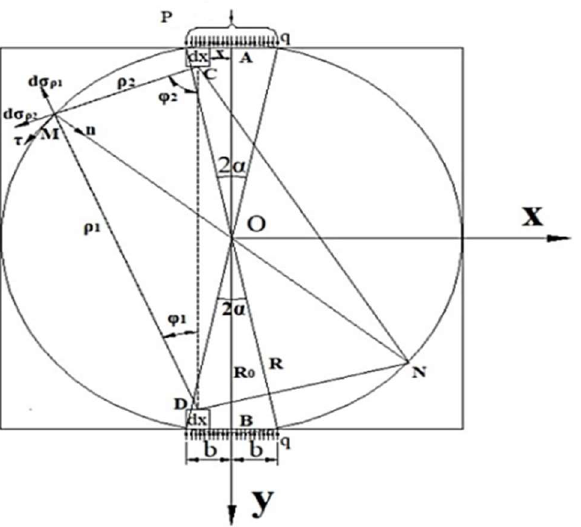
Figure 5. Calculation schematic diagram of the boundary stress mechanical model of the indirect tensile test of the interlayer bond. Through the point M, the diameter MN of the circle O is drawn, which is intersected with the circle O at points M and N. Since the microelement is small enough and the loading angles of the indenters are relatively small, it can be approximated that C and D are both on the circumference of the circle O. According to the circumferential angle theorem, the circumferential angle corresponding to the diameter is a right angle, therefore, ∠ MCN = ∠ MDN ≈ π /2. In line with the circumferential angle theorem and the central angle theorem, ∠ MNC = ∠ MDC = ϕ 1 and ∠ MND = ∠ MCD = ϕ 2 . Then, ∠ CMN = π /2 − ϕ 1 and ∠ DMN = π /2 − ϕ 2 . In accordance with the superposition of the